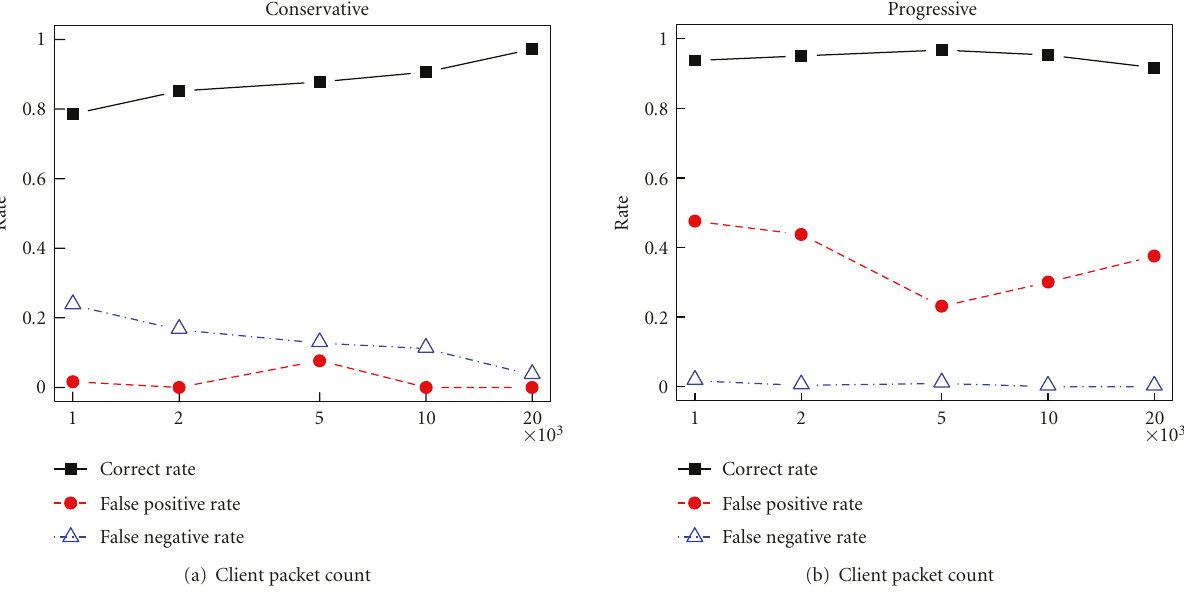
Figure 19: Evaluation results for the integrated schemes with di ff erent input size.